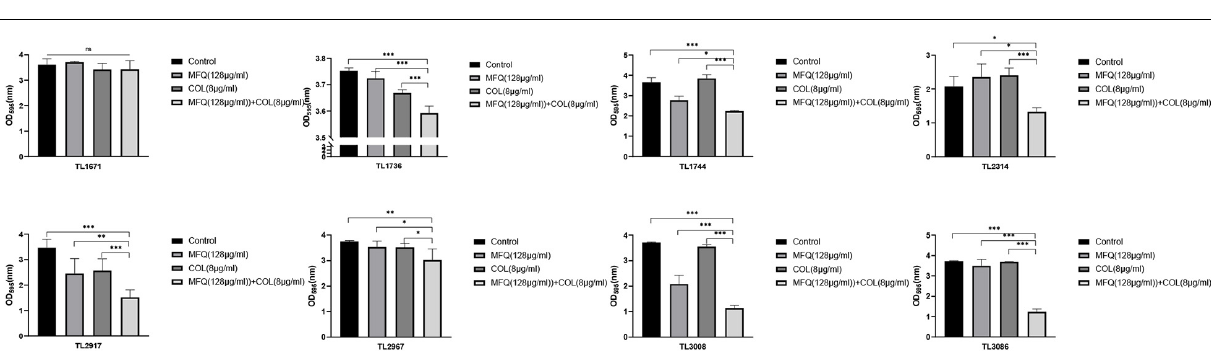
FIGURE 3 | Eradication effect of mefloquine combined with colistin on Pseudomonas aeruginosa mature biofilm. The selected drug concentration was derived from the Checkerboard method with FICI < 0.5. P < 0.05 (*), P < 0.01 (**), and P < 0.001 (***) analyzed by Student’s t -test. Mefloquine (MFQ) and colistin